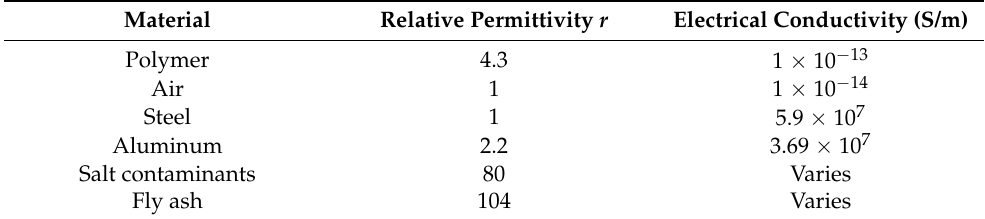
Table 2. Simulation material parameters.